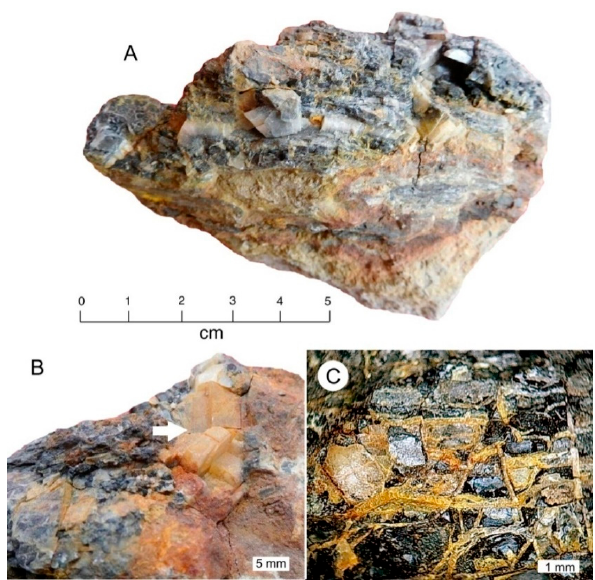
Figure 25. Uranium ore from Moab, Utah area, consisting of carbonized wood in a sandstone matrix. ( A ) Upper zone contains uranium-bearing carbonized wood, lower zone contains sandstone with local iron oxide staining. ( B ) Rhombic white calcite crystals are abundant within the wood layer. ( C ) Thin fracture networks in wood zone are filled with yellow barite.